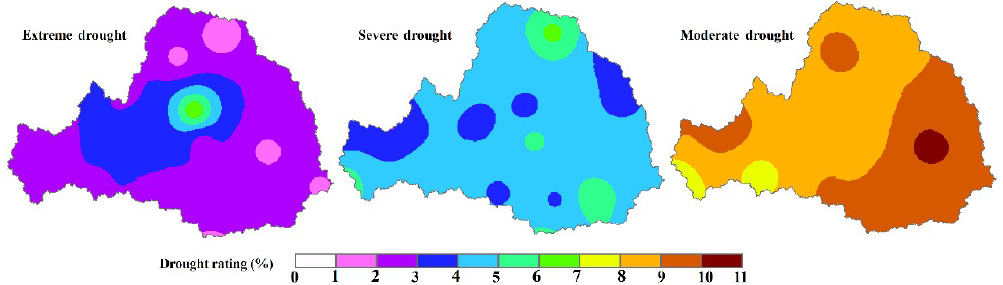
Figure 6. Drought rating of extreme drought, severe drought and moderate drought based on SPI-3 in the Wei River Basin during the period